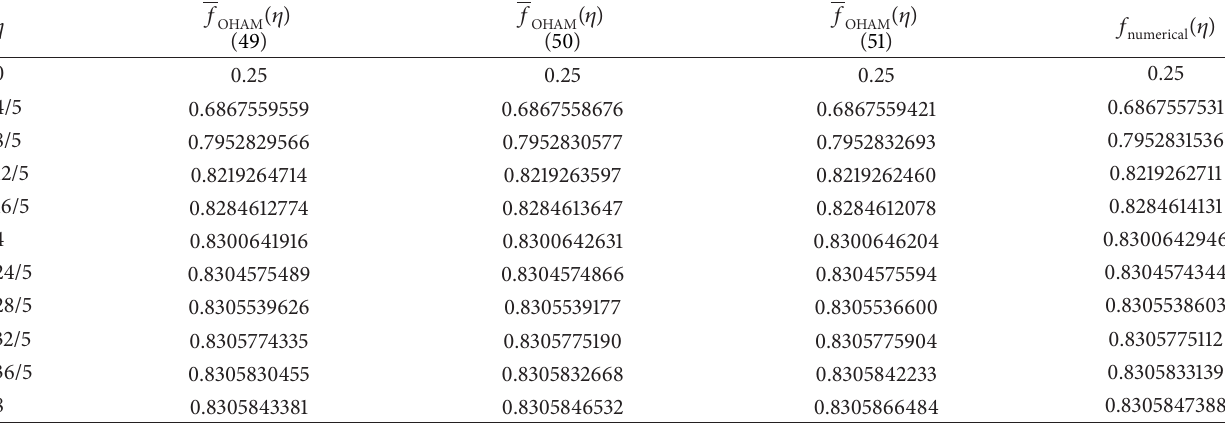
Table 2: Comparison of the first-order approximate solution 𝑓 obtained by OHAM with numerical results.